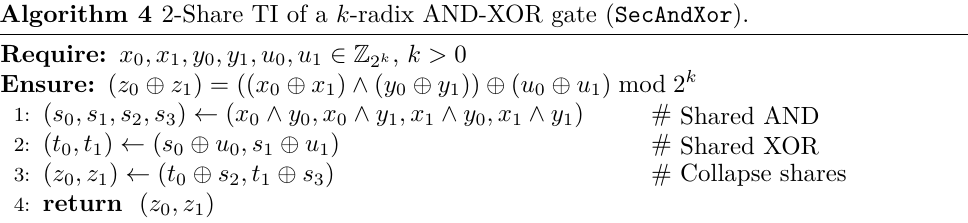
Algorithm 4 2-Share TI of a k -radix AND-XOR gate ( SecAndXor